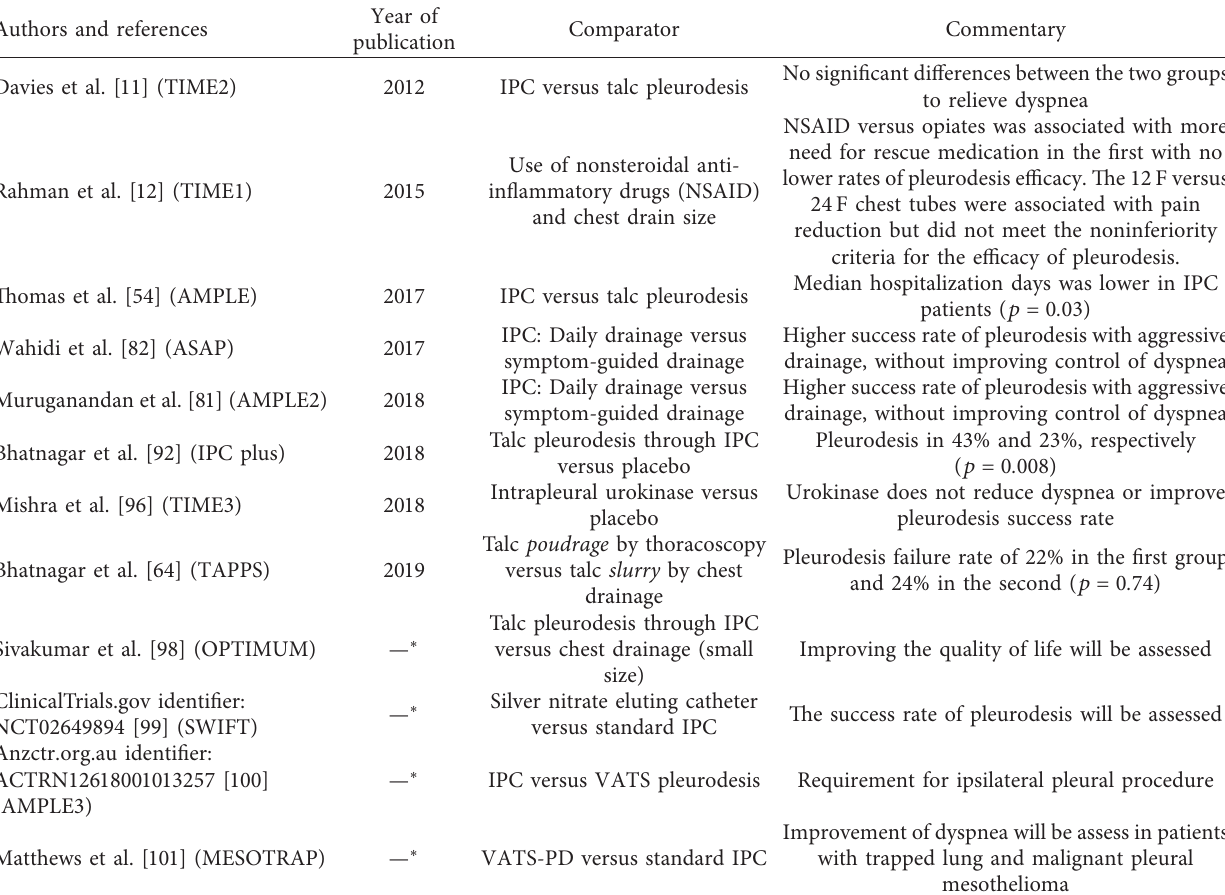
Figure 2: Recent trials addressing the management of malignant pleural effusion (modified under authorization) [41]. IPC, indwelling pleural catheter. ∗ In recruitment phase. Table 2: Main trials investigating management of malignant pleural